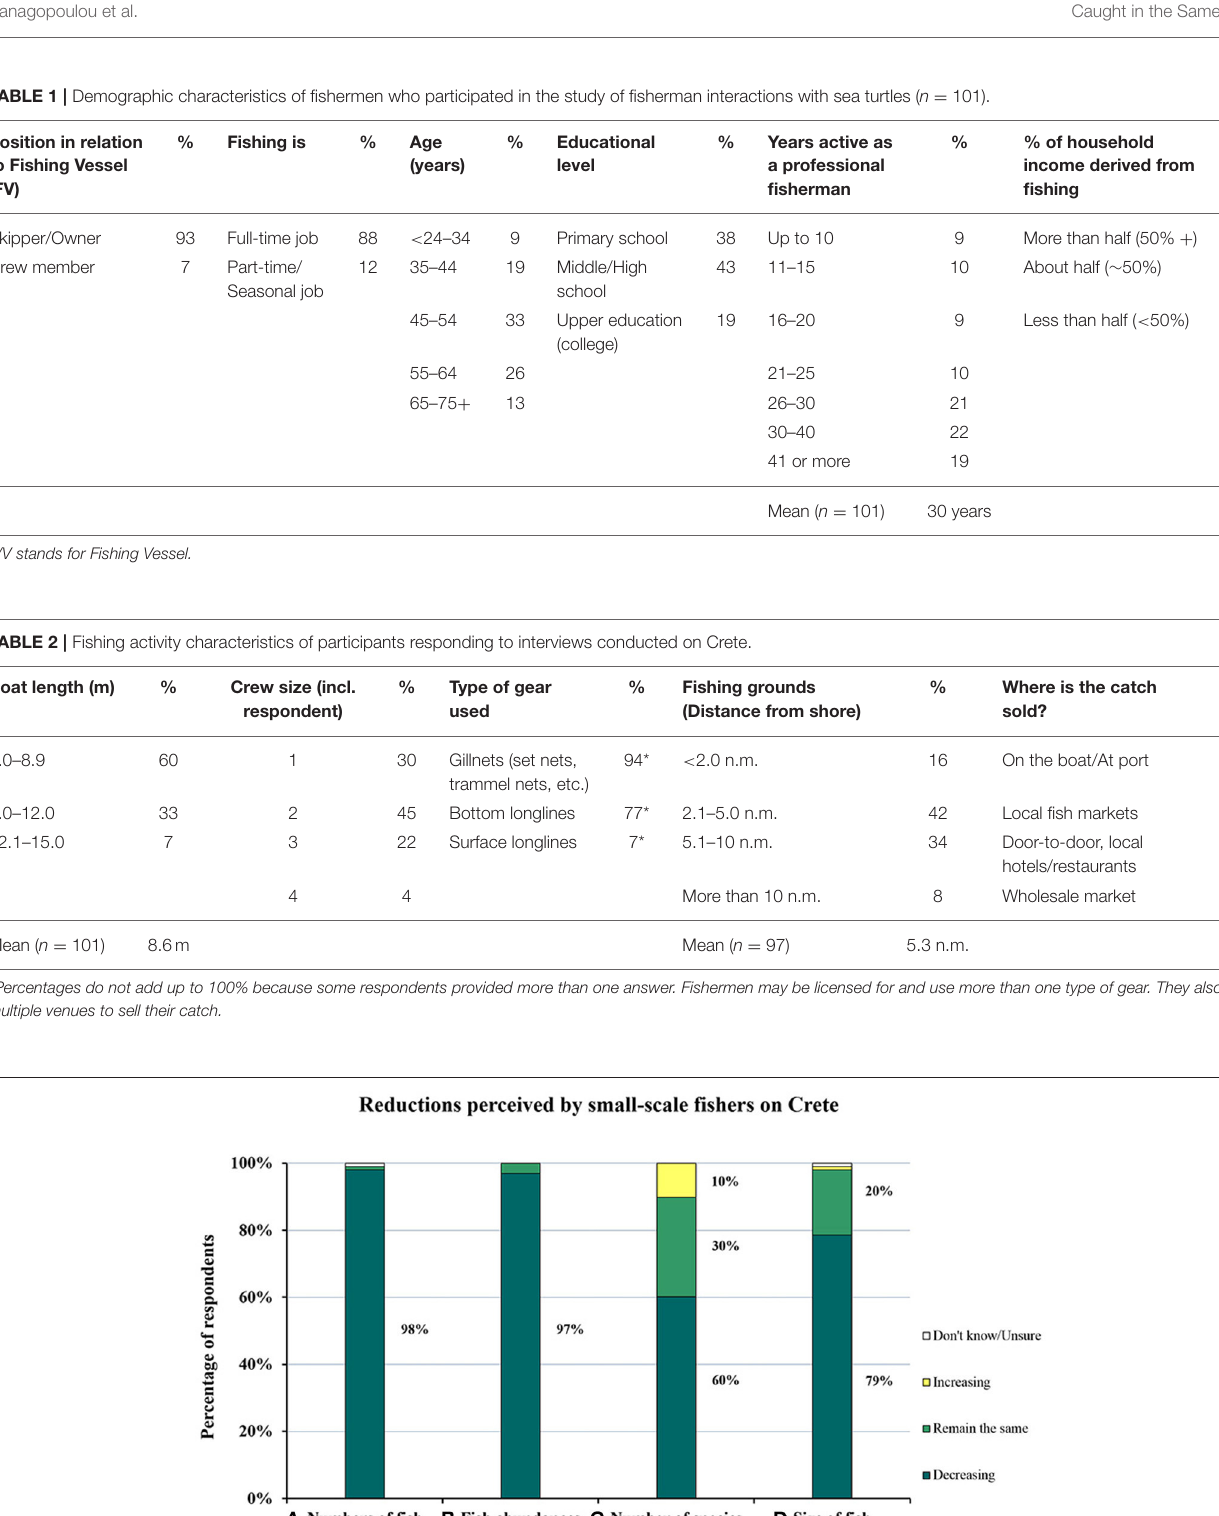
Frontiers in Marine Science | www.frontiersin.org